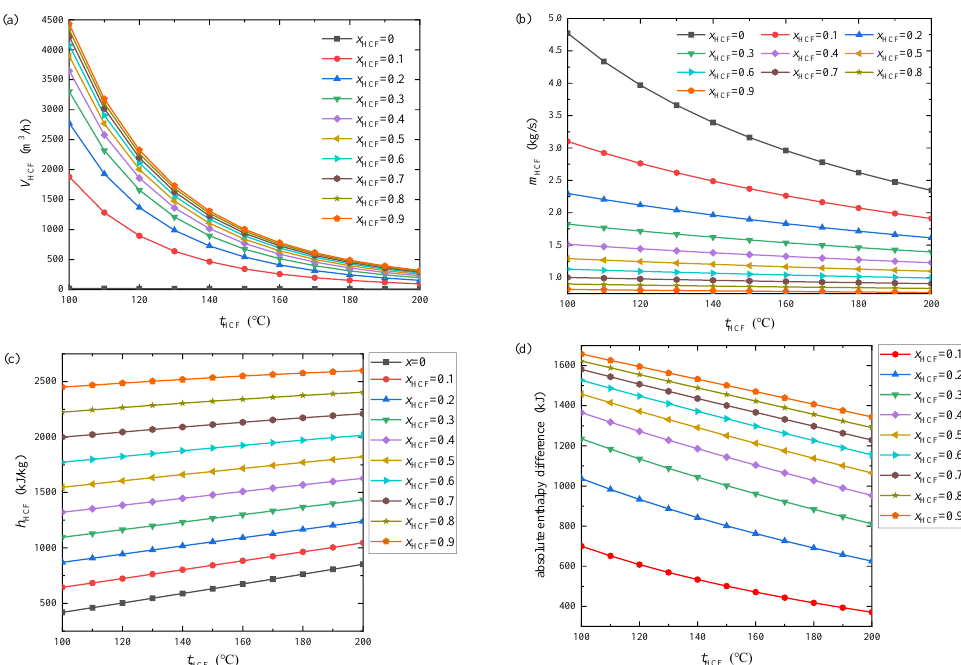
Figure 10. Variation curves of production capacity parameters of heat carrier with t HCF under different steam quality: ( a ) volume flow rate, ( b ) mass flow rate, ( c ) enthalpy and ( d ) absolute enthalpy difference.